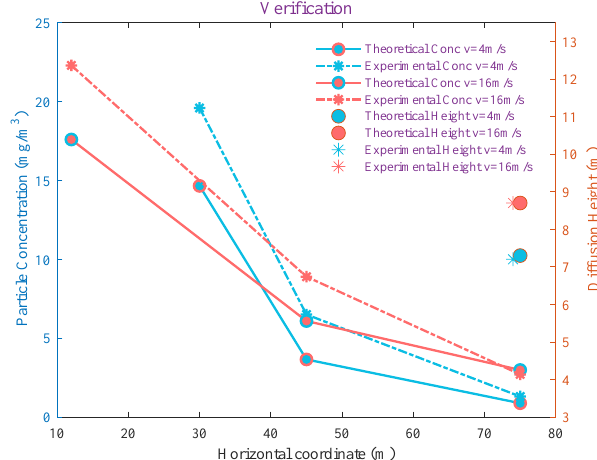
Figure 5. Model validation versus the field measurements.